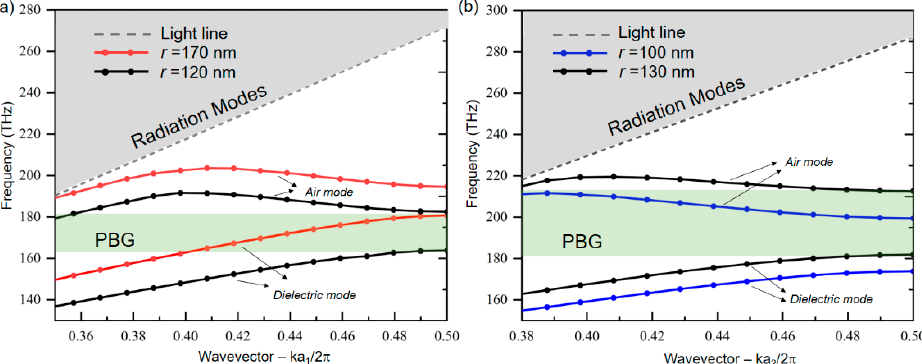
Figure 2. TE band diagram ( a ) for cav 1 ( b ) for cav 2 of the two independent PCNCs. Photonic bandgaps (PGB) are represented by light green regions.